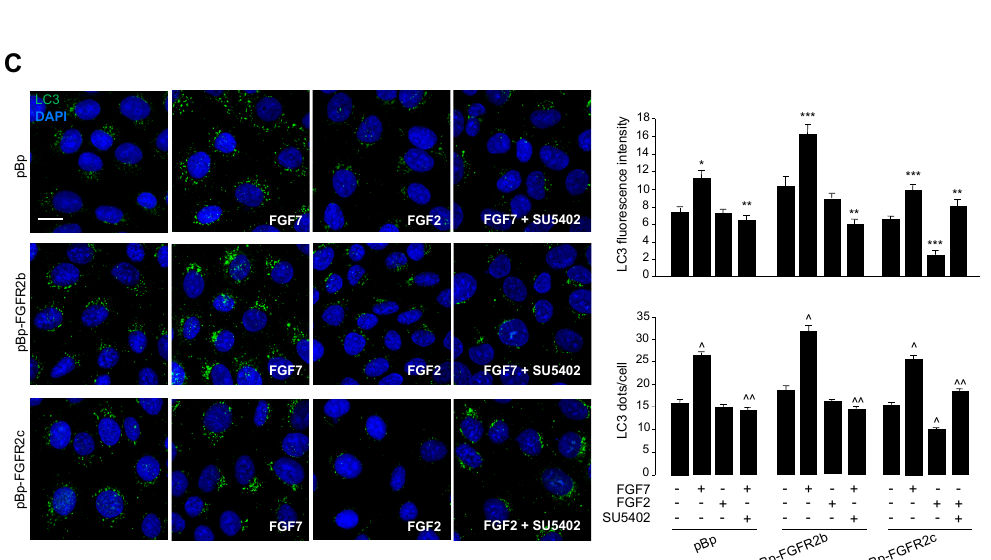
Figure 1. The ectopic expression of FGFR2c and its signaling inhibit autophagy in human keratinocytes. HaCaT cells, stably transduced with pBp-FGFR2b or pBp-FGFR2c constructs or with the empty pBp retroviral vector as control, were left untreated or stimulated with FGF7 or FGF2 in presence or absence of the FGFR2 tyrosine kinase inhibitor SU5402 as described in Material and Methods. ( A ) Western blot analysis showed that, while FGF7 stimulation increases the levels of LC3-II in all clones, FGF2 stimulation significantly decreased them only in HaCaT pBp-FGFR2c cells. All the observed e ff ects were abolished by the presence of SU5402. Equal loading was assessed with the anti-ACTB antibody. For the densitometric analysis the values from three independent experiments were normalized and expressed as fold increases and are reported as mean values ± standard deviations (SD). Student’s t test was performed, and significance levels are defined as P < 0.05. * p < 0.05 and *** p < 0.001 vs the corresponding FGF-unstimulated cells; ** p < 0.05 vs the corresponding SU5402-untreated cells; not significant (NS) vs the corresponding FGF-unstimulated, SU5402-untreated cells. ( B ) Real-time Reverse Transcriptase-Polymerase Chain Reaction (RT-PCR) analysis shows that while FGF7 stimulation